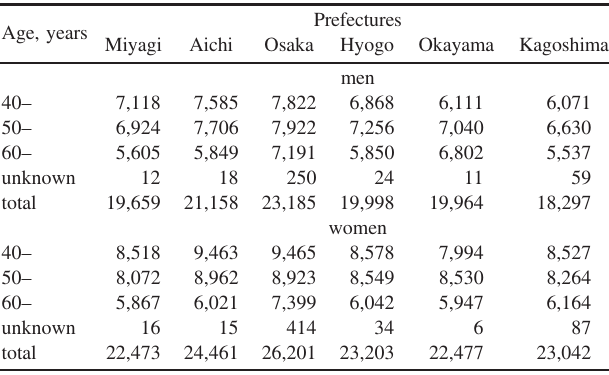
Table 2. Study population by sex, age group and prefecture Age,